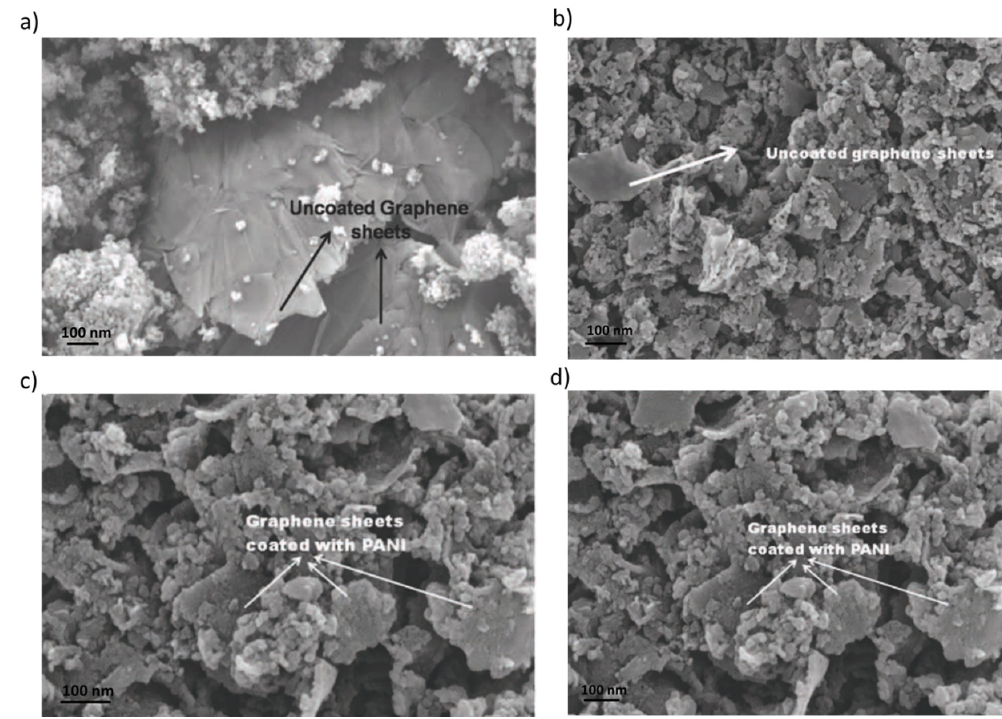
Figure 11. FESEM images of pristine graphene-based nanocomposites wrapped with ( a ) PANI and ( b ) PPy and modified graphene-based with ( c ) PANI and ( d ) PPy, at a magnification of 260.00 KX except for ( a ) 200.00 KX (adapted from [6]).